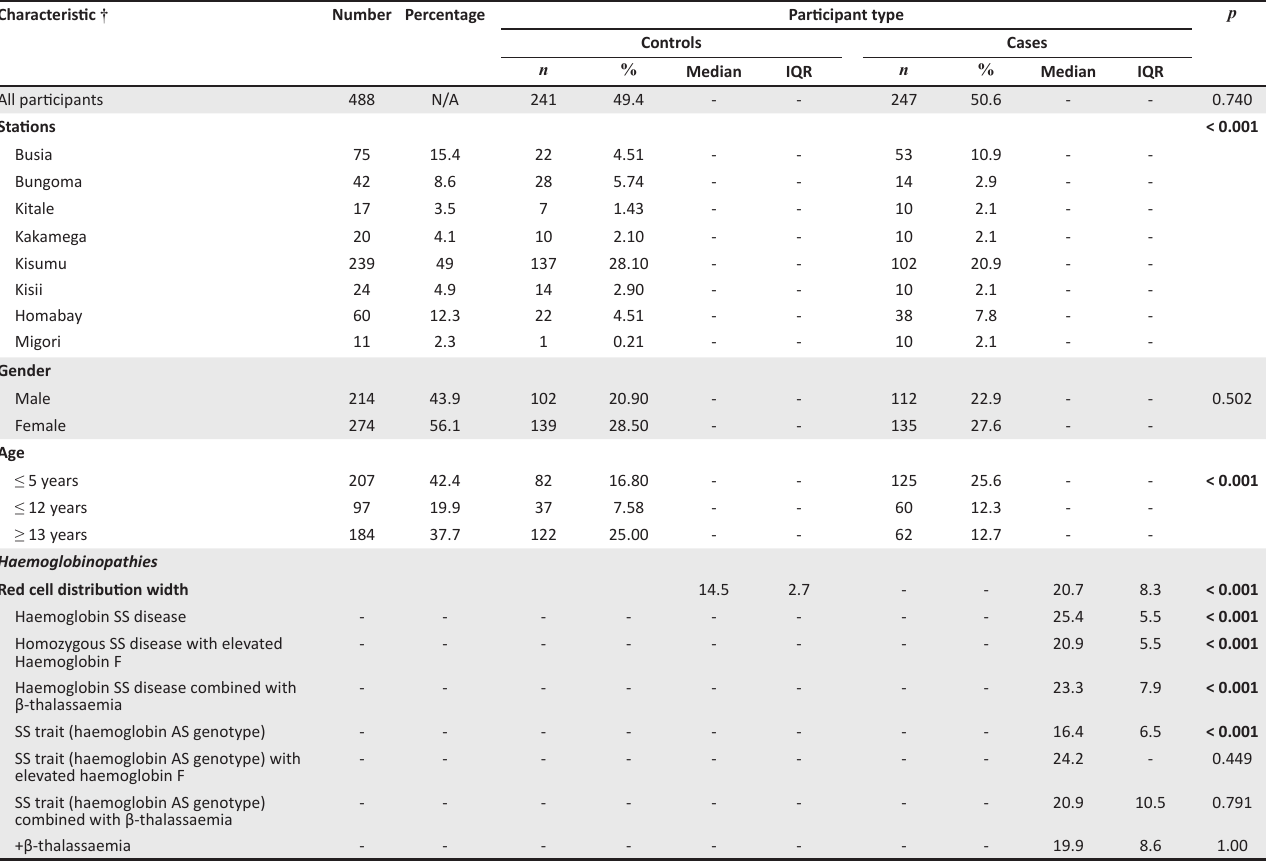
TABLE 1: Demographic characteristics of study participants and RDW in control and case (haemoglobinopathies) groups in western Kenya, 01 January 2015 – 31 December 2020. Characteristic †